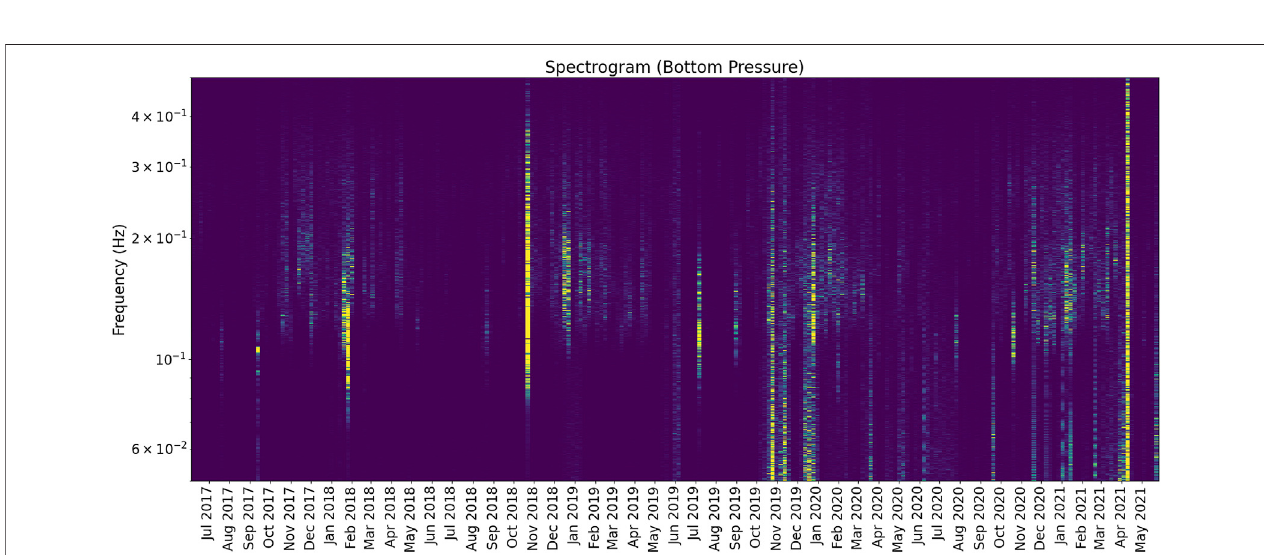
FIGURE 10 | Spectrogram of the 1 Hz bottom pressure data. Storm events are characterized by higher wave heights, which translates into stronger frequency constituentswithperiodsbelow20 s(brightcolors).Theverticalaxisislogarithmicandrangesfrom0.05 Hz(bottom,T=20 s)uptotheNyquistfrequencyof0.5 Hz(top, T = 2 s).